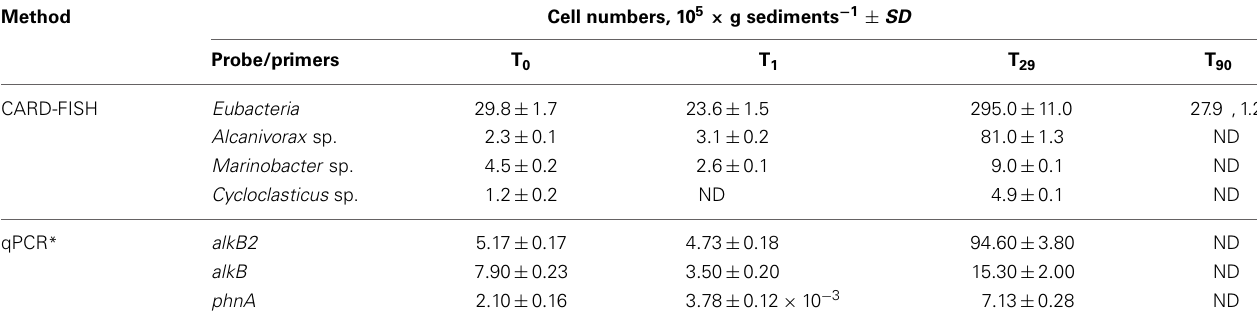
Table 3 | CARD-FISH and qPCR cell number quantification in the MSS internal sediment during the bioremediation treatment.